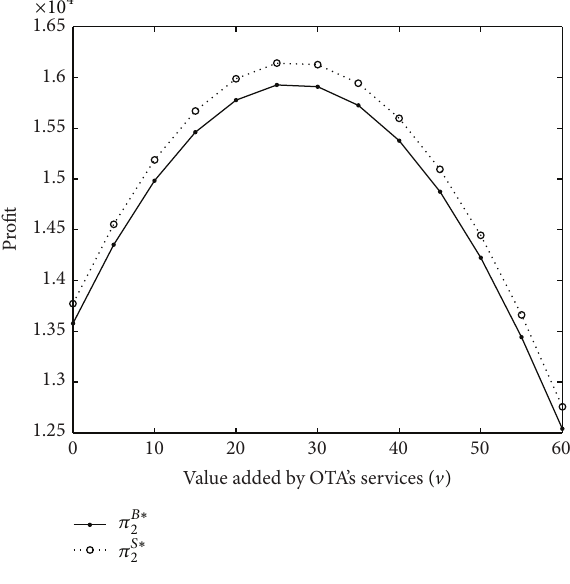
Figure 4: OTA’s profits under two games.